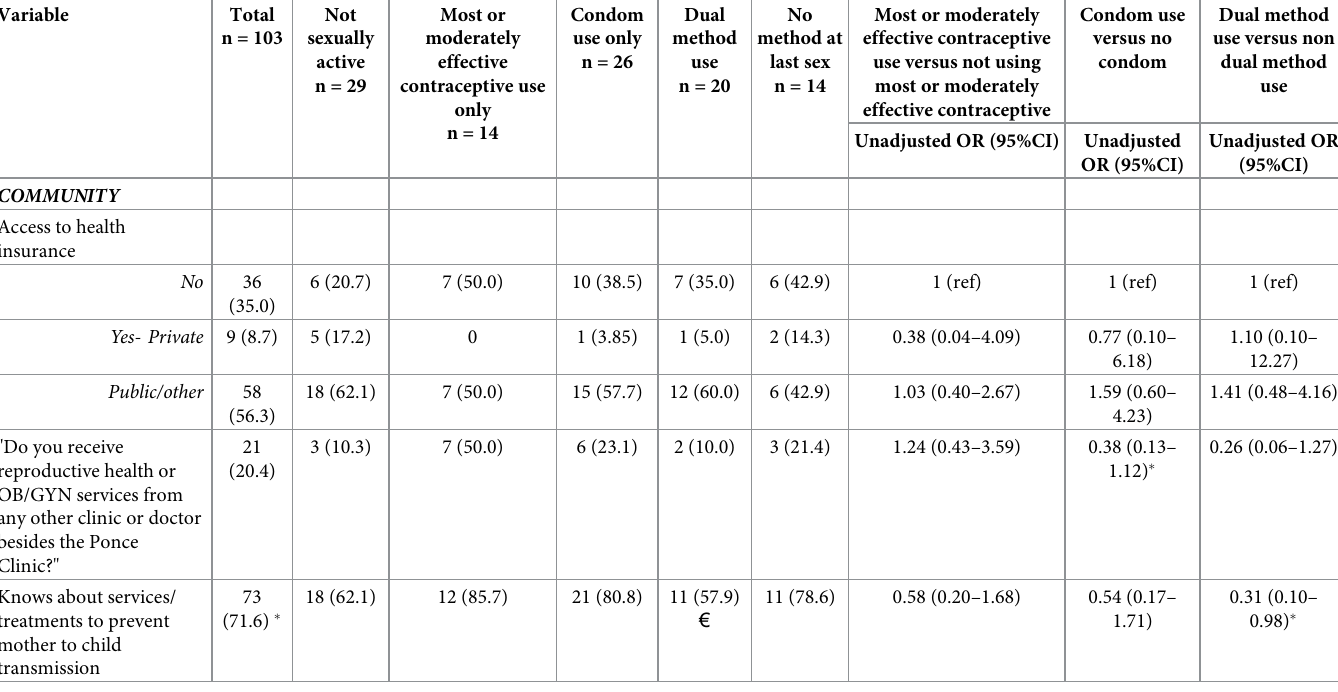
Table 3. Description of community-level factors among young HIV-infected study participants and association between these factors and most or moderately effec- tive contraception use only, condom use only, and dual method use at last coitus.